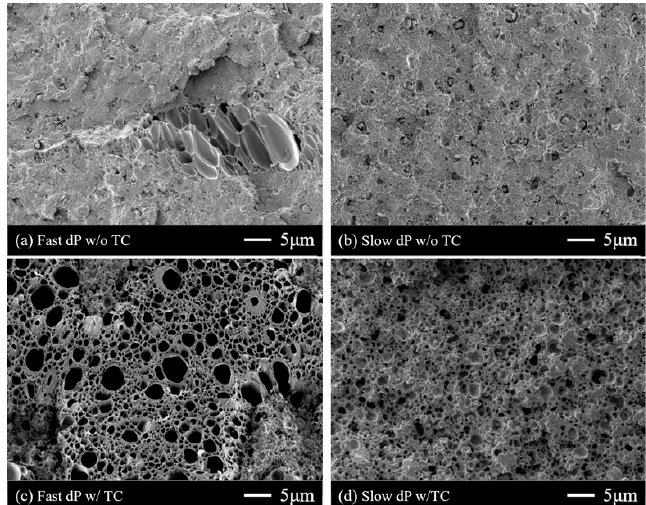
Figure 5. SEM images of processed ABS/PET blends after ( a ) depressurization for 1 s, ( b ) depressurization for 3 min, ( c ) depressurization for 1 s and thermal contrast at 120 ◦ C, and ( d ) depressurization for 3 min and thermal contrast at 120 ◦ C. When the thermal contrast was performed after depressurization, a large number of cells appeared. Table 4. The properties of the ABS/R-PET blends foamed at 120 ◦ C after fast or slow depressurization. Depressurization Mean Cell Diameter, Rate Depressurization